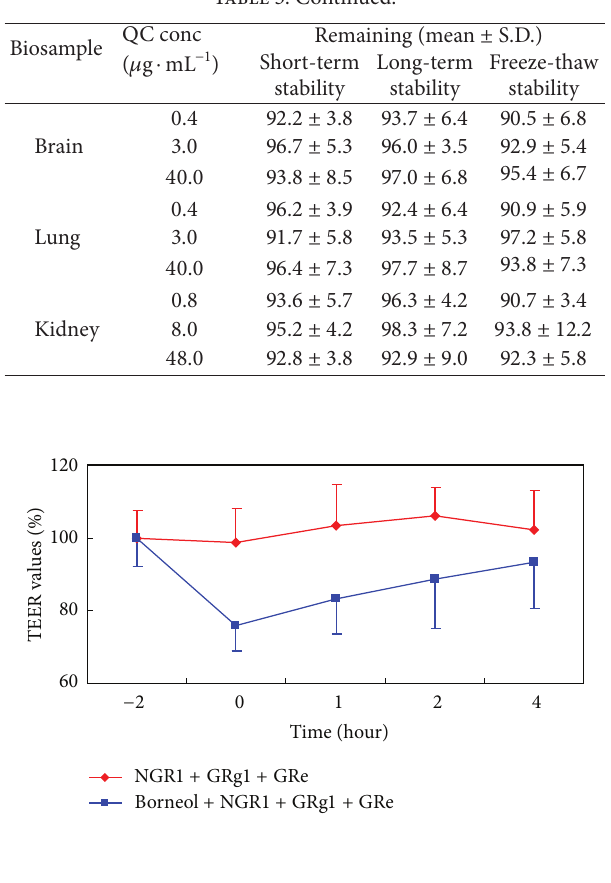
Figure 3: Effect of Borneol on TEER values of the Caco-2 cell monolayers. The Caco-2 cell monolayers were pretreated 2h with 500 𝜇 M of NGR1, GRg1, and GRe, or the three saponins plus 200 𝜇 M Borneol. At time point 0, the monolayers were washed with buffered DMEM (pH 7.4), and then incubated at 37 ∘ C for